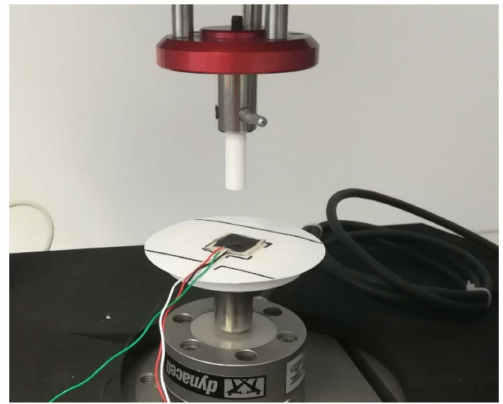
Figure 5. Compression force test